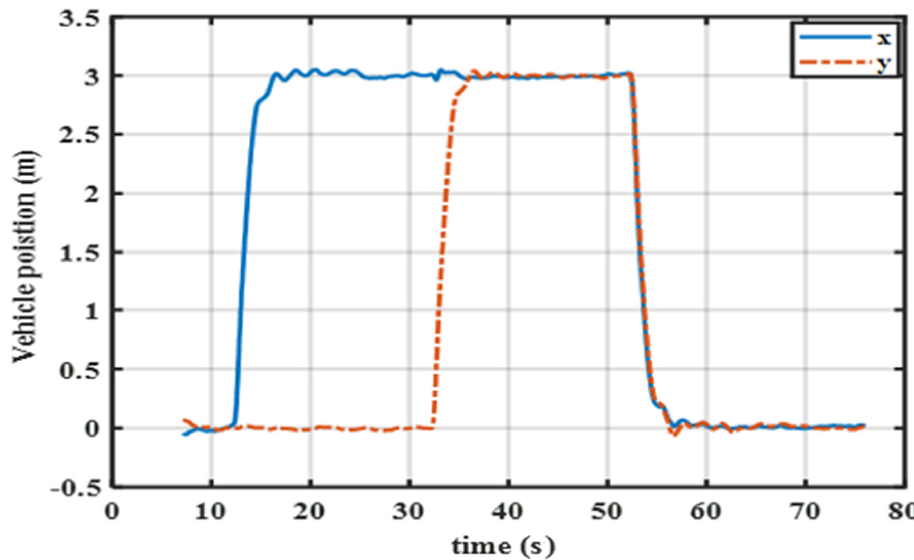
Figure 22. Time history of the quadrotor position during travel maneuver without the ASC.